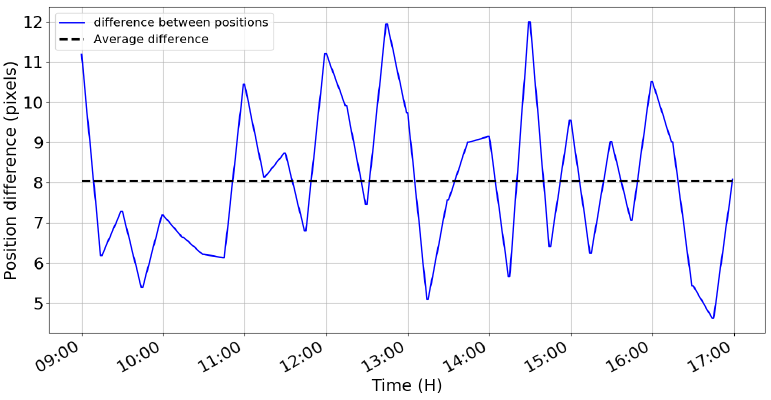
Figure 14. Difference of positions between segmentation and particle